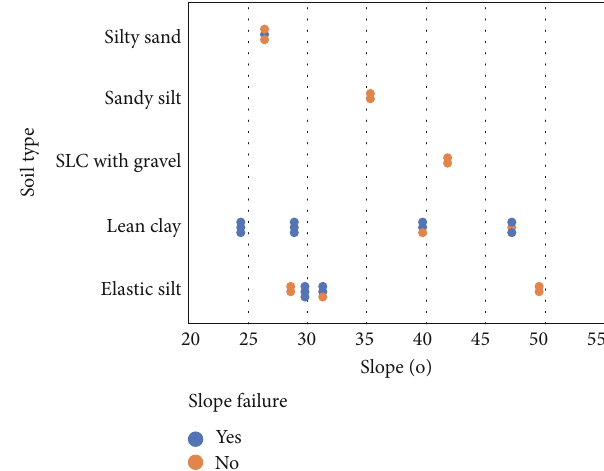
Figure 13: Slope failure vs. slope angle and land cover.